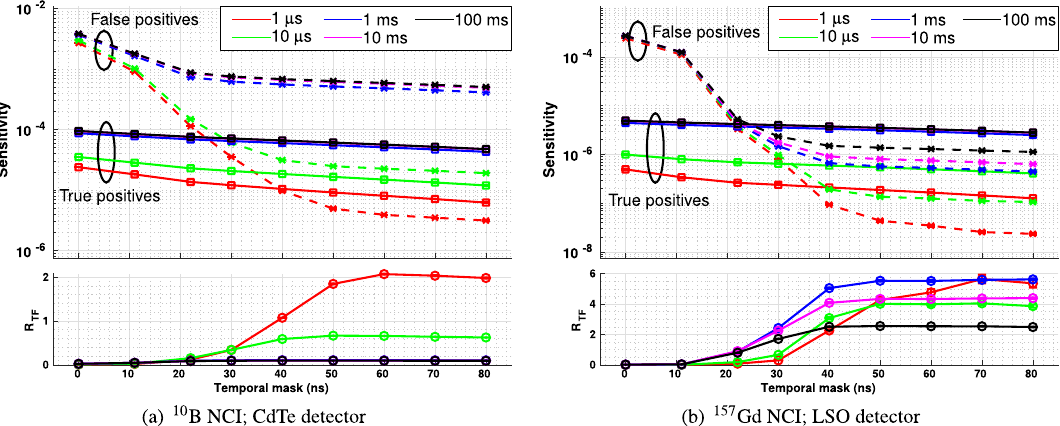
Figure 9. Sensitivity (upper plot) and R TF (lower plot) for all detected events following target irradiation by a carbon ion beam as a function of temporal mask duration for a range of different irradiation periods. In all plots, the red markers denote a total irradiation time of 1 µs, green 10 µs, blue 1 ms, magenta 10 ms and black 100 ms. In the upper plots in each subfigure, square markers ( (cid:31) ) joined by unbroken lines denote true positives, while cross markers ( × ) joined by dashed lines denote false